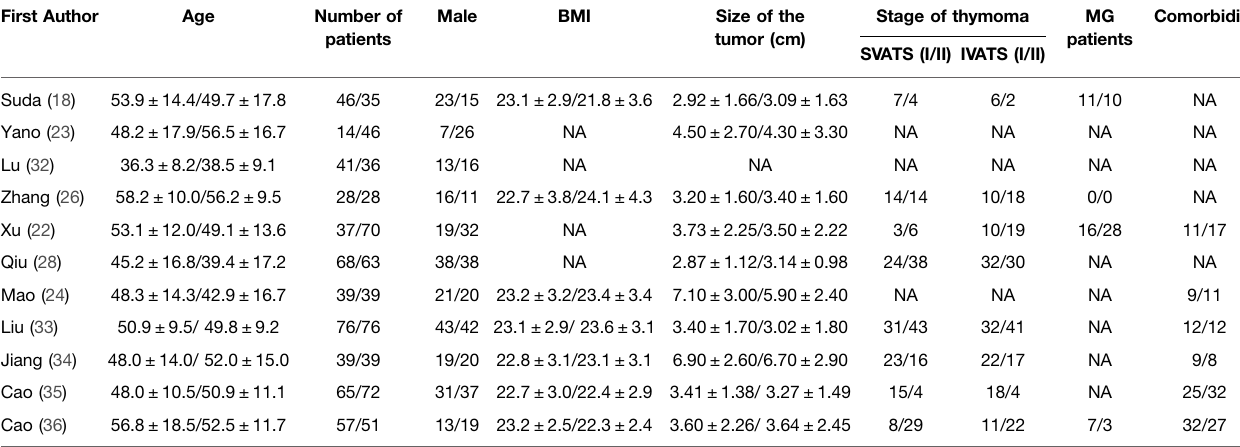
TABLE 2 | Baseline information of included articles (SVATS/IVATS).